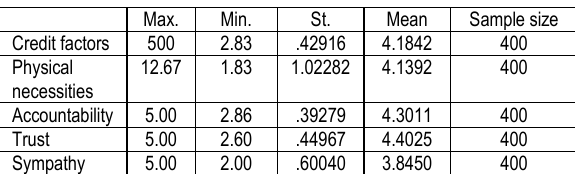
Table 1. Results of descriptive statistics (hypotheses